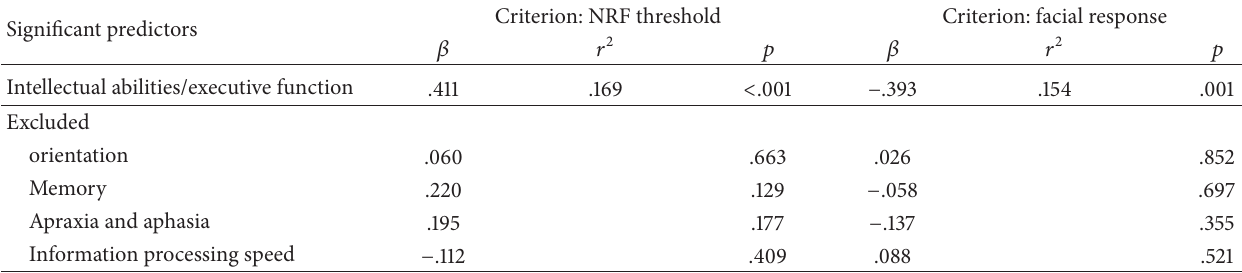
Table 3: Linear regressions analyses (forward selection) predicting variances in pain responsiveness (NFR threshold and facial responses).